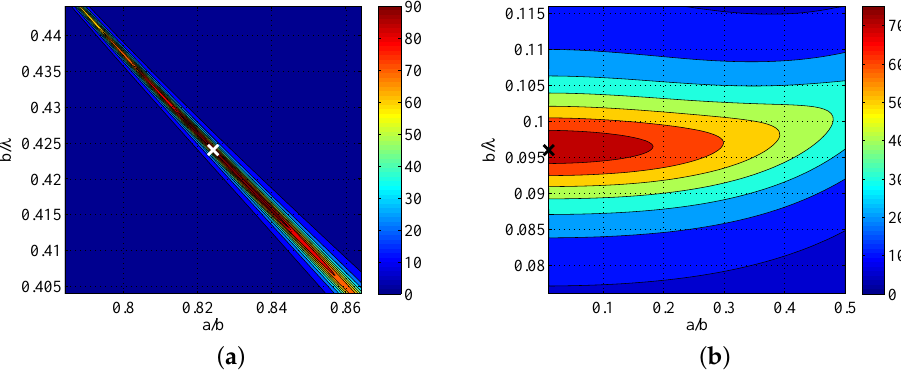
Figure 7. Relative radiative power P rad / P inc variation with respect to changes in aspect ratio a / b and electrical size b / λ around the optimal designs (marked by × ) of: ( a ) TM waves of the Ag cladding of Figure 4 at λ = 693 nm and ( b ) TE waves of the GaP cladding of Figure 5 at λ = 460